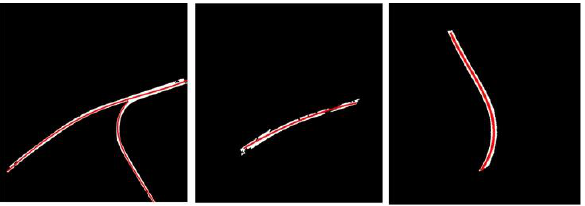
Figure 8. Cubic Function Expressions of the passages